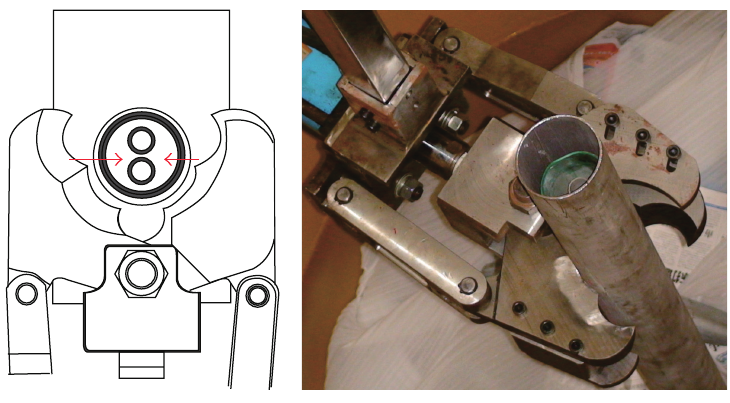
Figure 7: Parallel